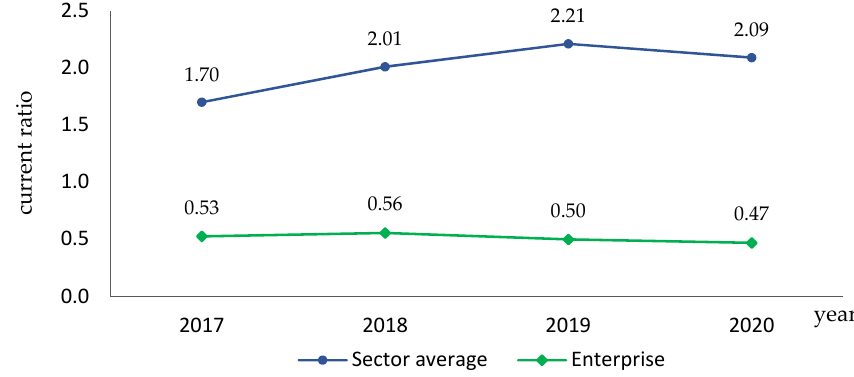
Figure 6. Operating profitability of assets ( y 2 ) in the enterprise and in the sector in 2017–2020 (%).